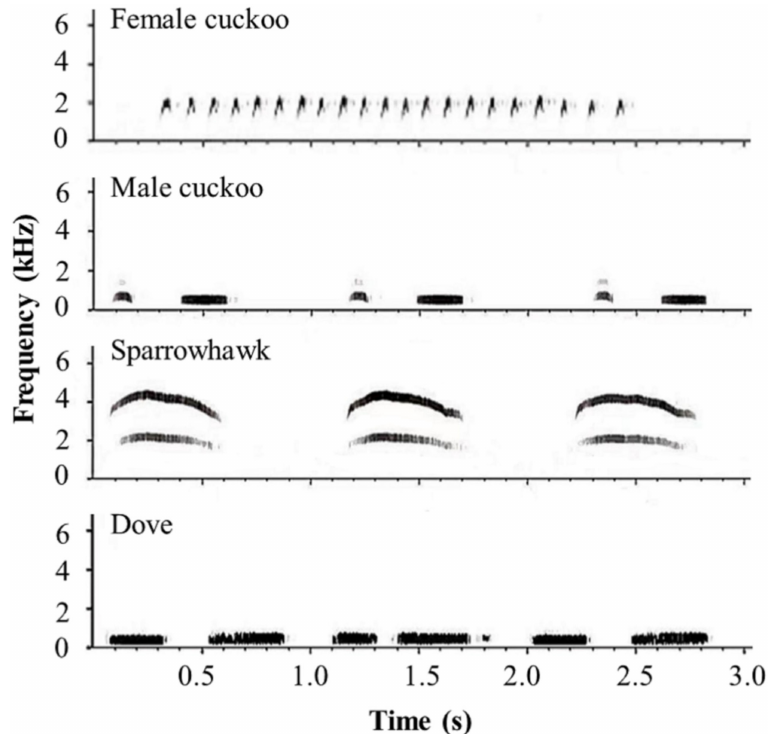
Figure 1. The spectrograms of four call types used in the playback